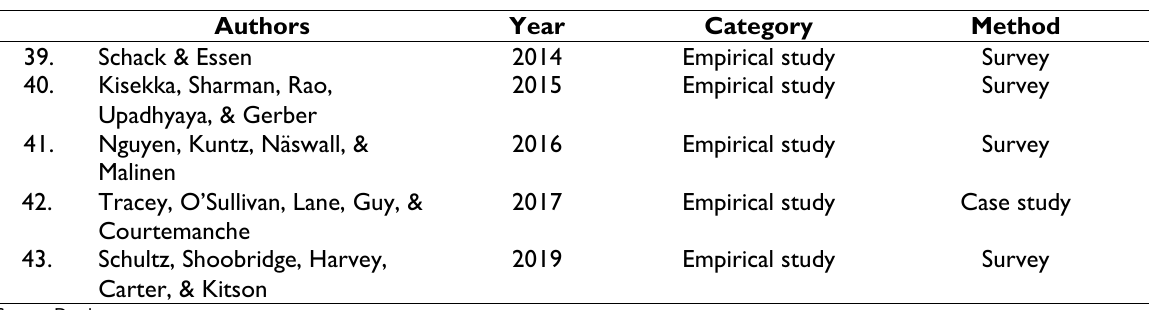
Table 3: Articles in Other Fields